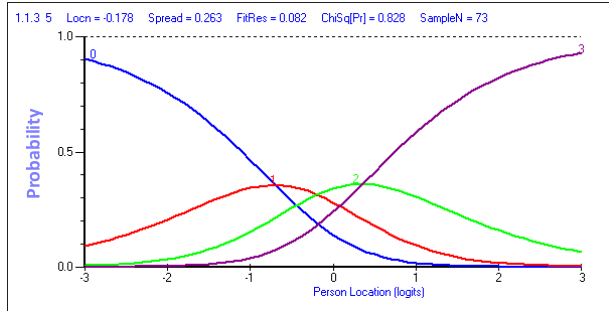
FIGURE 13: Final category probability curve for Item 1.1.3